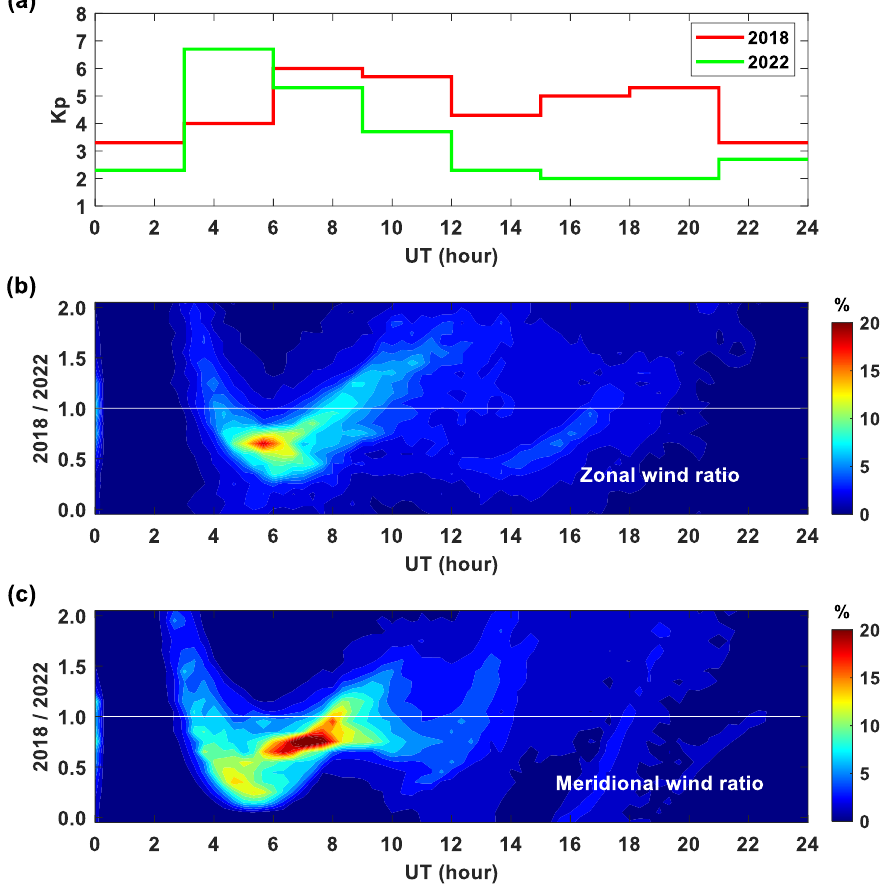
Figure 6. ( a ) The red line represents the Kp values on 20 April 2018 and the green line stands for the Kp values on 10 April 2022. ( b ) Each grid zonal wind velocity during the 2018 storm is divided by the 2022 zonal wind velocity on the same grid to obtain the ratio of the zonal wind speed for two events in each grid. Then, the number of grids are counted in each ratio and its proportion to the total number of grids is calculated. The figure shows the statistical distribution of zonal wind ratios (2018/2022) of grids from 50 ◦ S to 90 ◦ S in the two events over time, where >1 (<1) represents a larger zonal wind velocity in the 2018 (2022) storm. ( c ) Same as ( b ), but corresponding to the meridional wind.